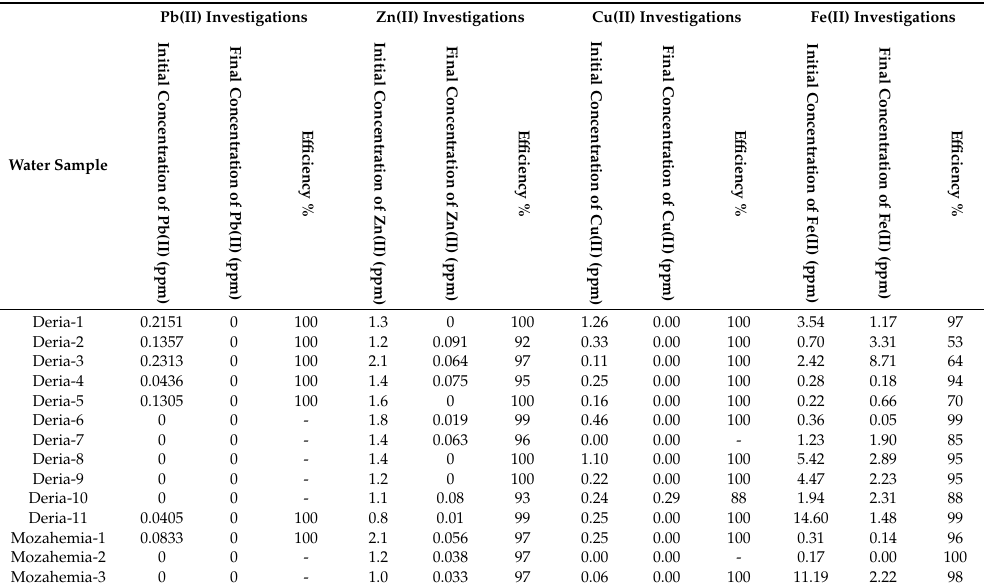
Table 3. E ffi ciency of the removal of Pb(II), Zn(II), Cu(II), and Fe(II) from di ff erent water samples from Deria and